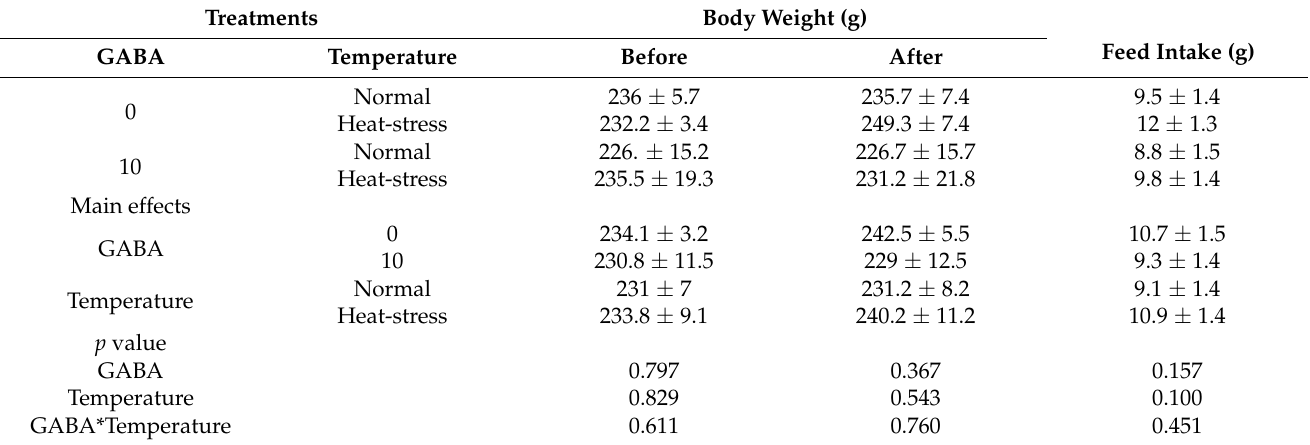
Table 5. Effect of in ovo injection of GABA on body weight variation of 10-day-old chicks exposed to acute heat stress for 3